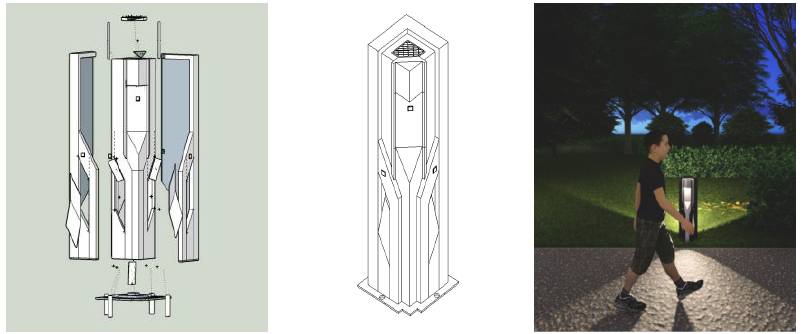
Figure 11. Structure design of the lawn lamp.